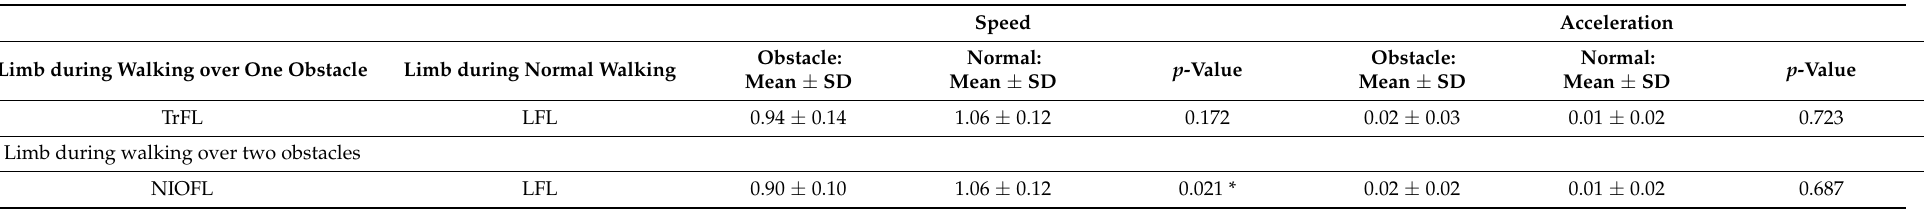
Table A5. Mean values, standard deviations, and significant differences in speed and acceleration between walking over one and two obstacles and normal walking. Speed Acceleration Limb during Walking over One